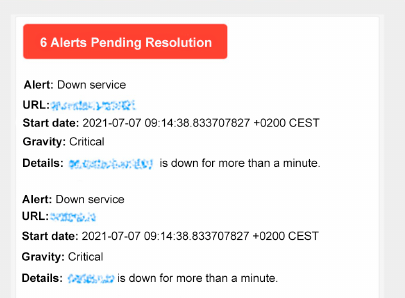
Figure 12. Example of an alert forwarded using Prometheus AlertManager